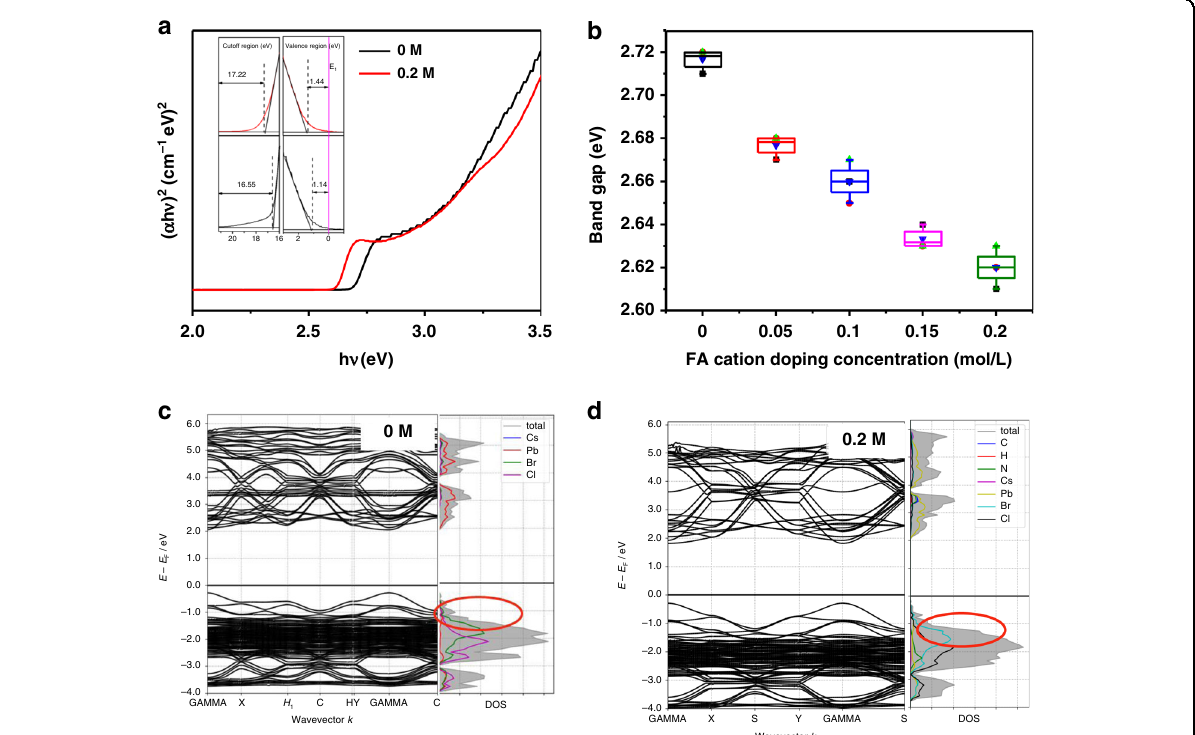
Fig. 5 Electron state fi lling of QDs. a Tauc plots of pristine and 0.2 M FA cation doped QD fi lms. The inset is UPS spectra of both fi lms. b Optical band gap changing with FA cation increase. c Left: calculated band structures of pristine CsPb(Cl 0.5 Br 0.5 ) 3 , and right: corresponding density of states (DOS). d Left: calculated band structures of FA cation doped CsPb(Cl 0.5 Br 0.5 ) 3 , and right: corresponding